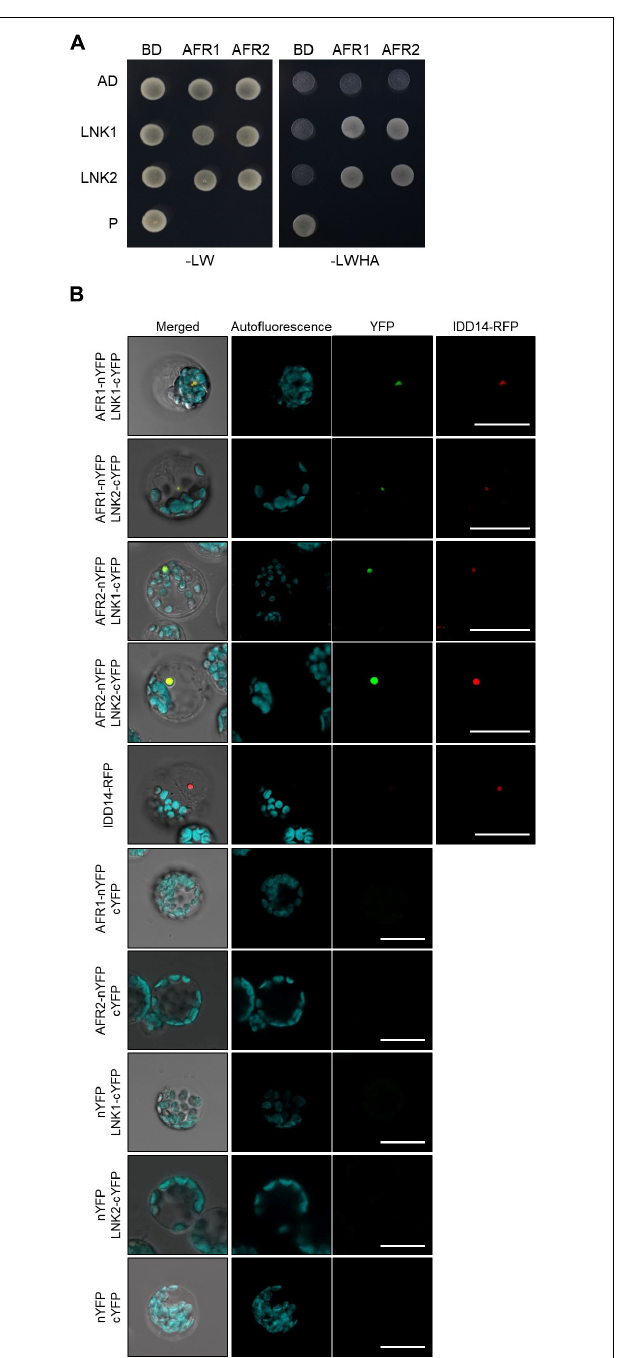
FIGURE 7 | Interactions of AFRs with LNKs. (A) Y2H assays. Y2H assays were performed with AFR proteins fused to the DNA-binding domain (BD) of GAL4 and LNKs fused with the transcriptional activation domain (AD) of GAL4 for analysis of interactions. Interactions were examined by cell growth on selective media. -LWHA indicates Leu, Trp, His, and Ade drop-out plates. -LW indicates Leu and Trp drop-out plates. GAL4 was used as a positive control (P). (B) BiFC assays. Partial fragments of YFP protein were fused with AFRs and LNKs, and co-expressed in Arabidopsis protoplasts. The IDD14-RFP construct was used as a nuclear marker. Reconstituted fluorescence was examined by confocal microscopy. Scale bars: 20 µ